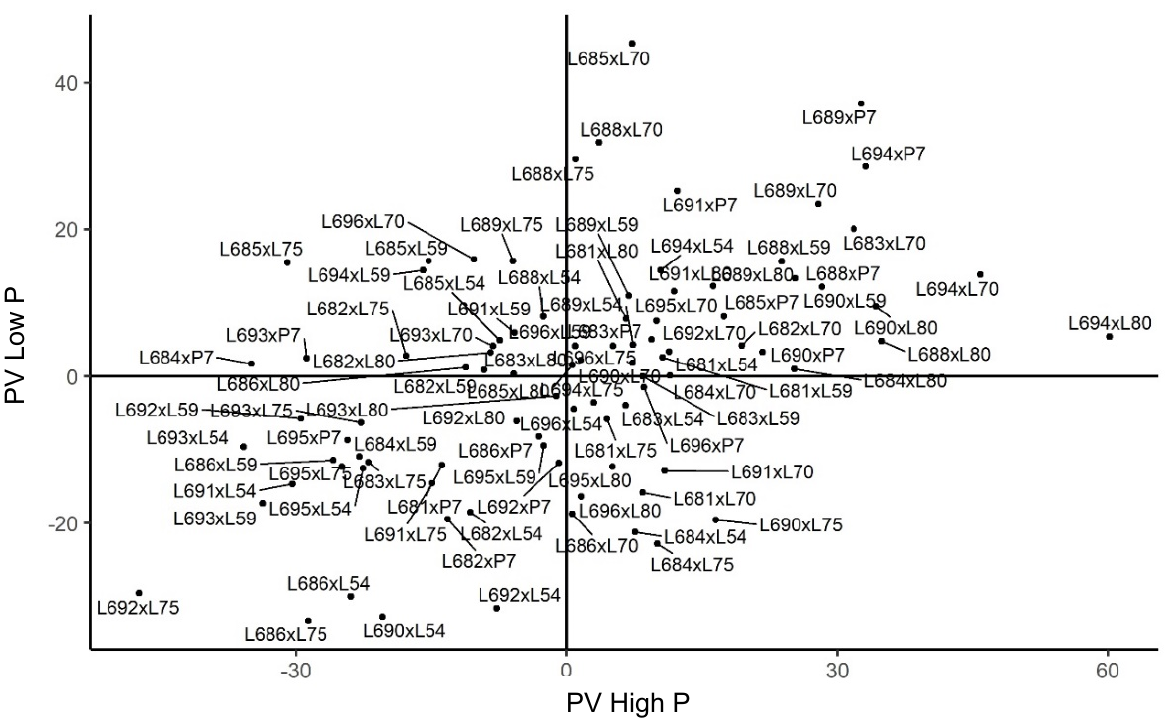
Figure 8. Estimates of the genotypic value (ˆ s ij ) for expanded popcorn volume per hectare (PV) in diallel hybrids of popcorn evaluated under high and low phosphorus availability in Itaocara. ( − ) signal indicating negative values.